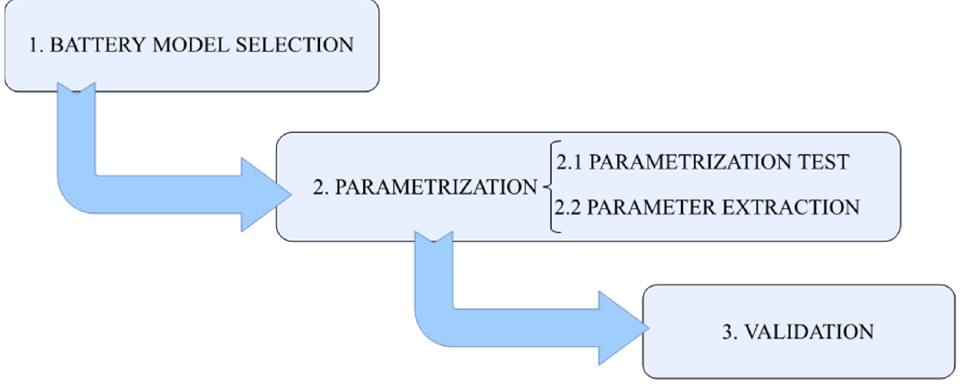
Figure 1. Battery model parametrization methodology .